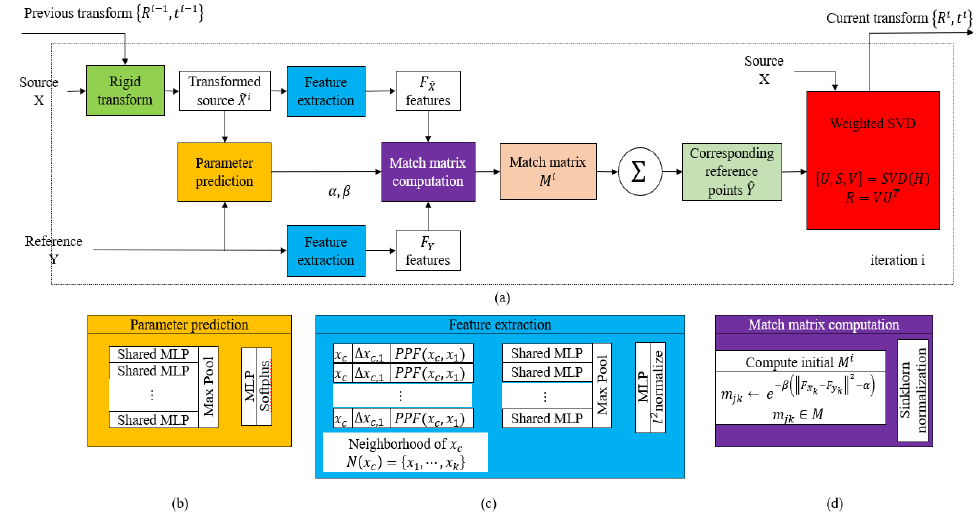
Figure 7. Illustrations of the RPM-net: ( a ) Overview of the RPM-net, ( b ) parameters predication network, ( c ) feature extraction network, and ( d ) computation of match matrix M; superscripts indicate the iteration count.